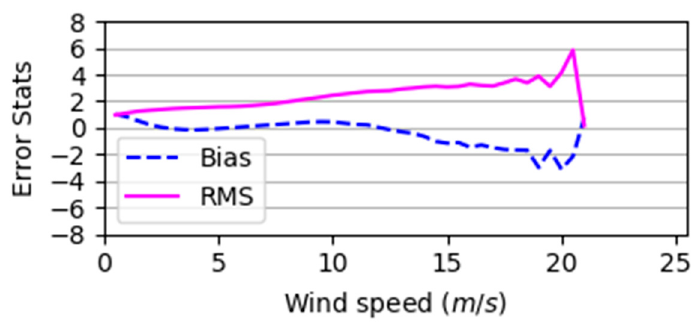
Figure 8. Root Mean Square and bias from Numerical Weather Prediction derived sea surface wind speed in different wind bins.